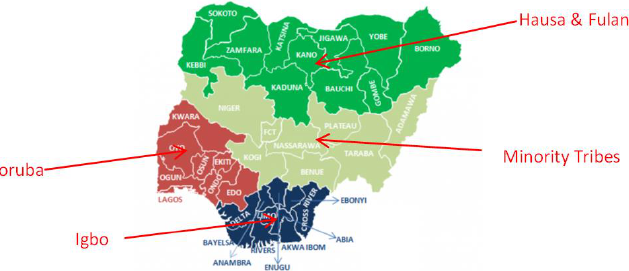
Figure 3. Map of Nigeria Showing the Broad Distribution of Major Ethnic Groups6. Source: